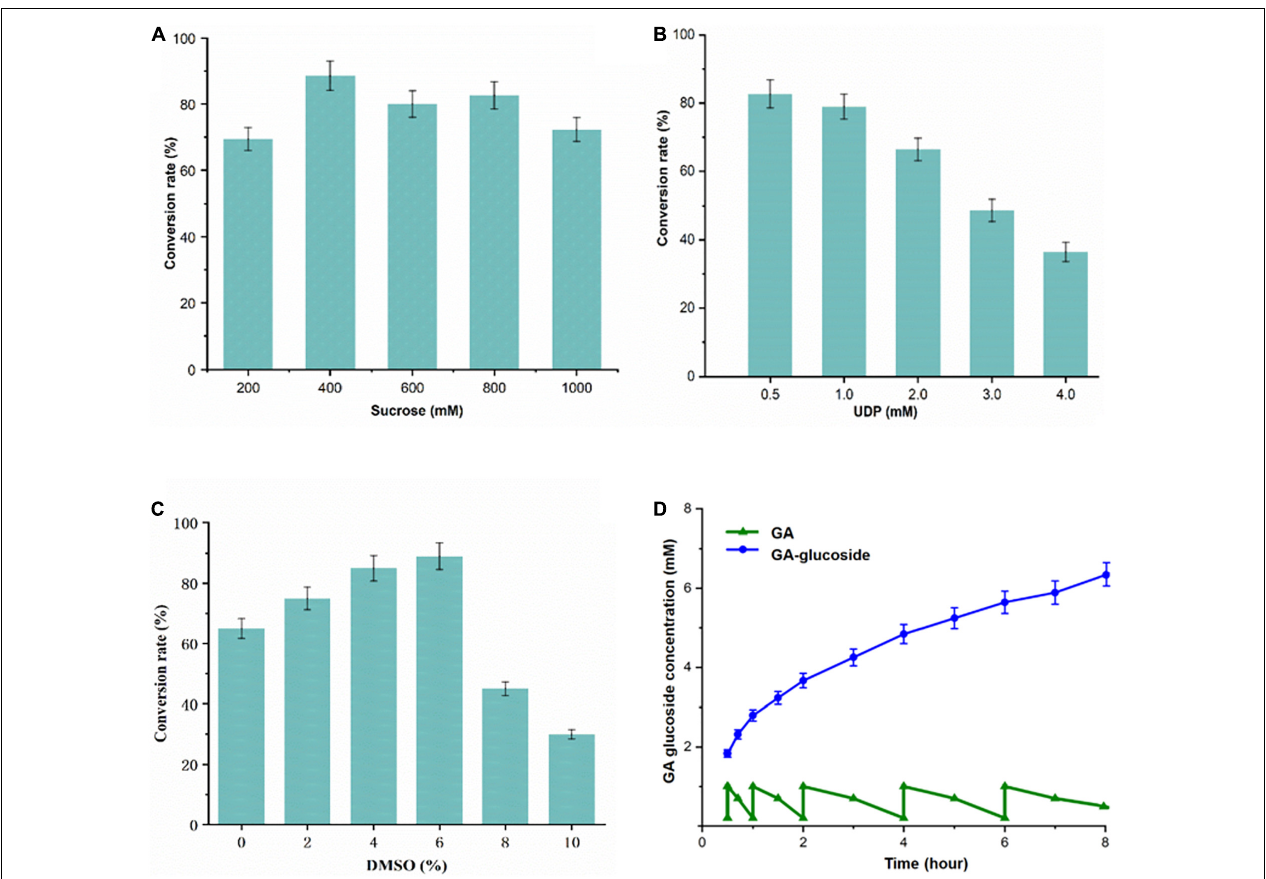
FIGURE 6 | (A–C) Optimization of the UGT109A3-SUS biocatalytic cascade reactions and (D) fed-batch synthesis of GA glycosides. A total of 1 mM GA dissolved in DMSO was added stepwise to the reaction mixtures with 50 µ g/mL UGT109A3 and 20 µ g/mL SUS at 0.5, 1, 2, 4, 6, and 8 h. Fresh enzyme was added at 4 h. Data represents the mean value ± standard deviation of three measurements.